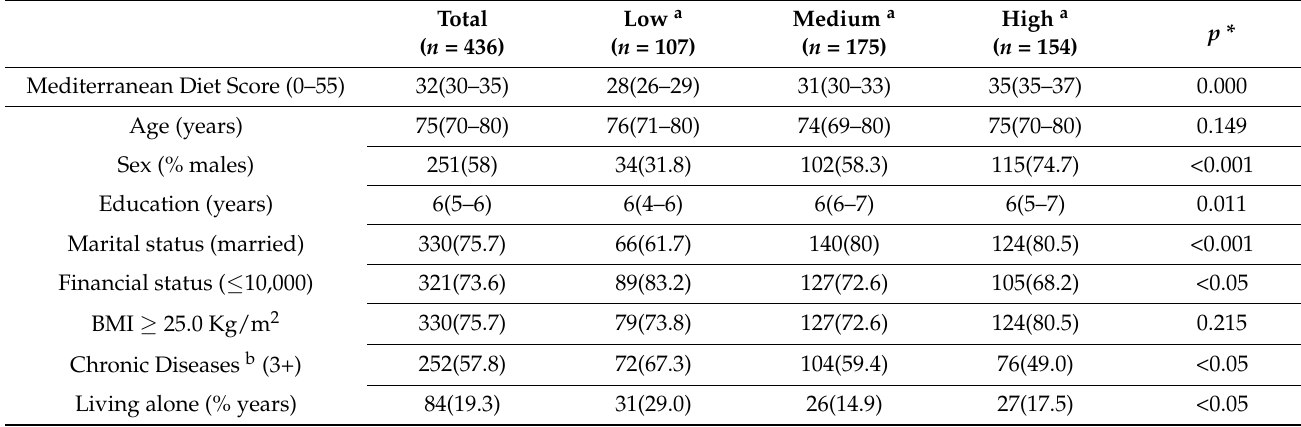
Table 1. Differences in demographic, anthropometric and health related characteristics per Mediterranean Diet adherence level ( n = 436).